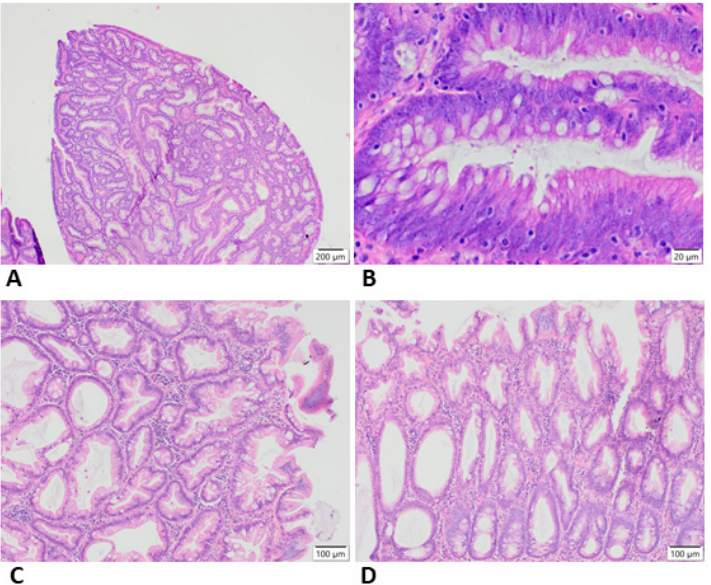
Figure 3. Representative histopathological appearance of adenomatous ( A , B ) and serrated ( C , D ) changes in the colon.